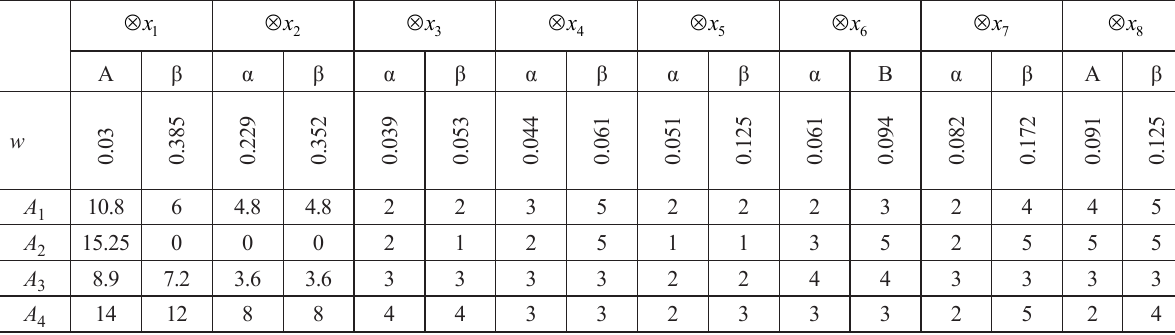
Table 5. Weight factors, criteria and alternatives of the proposed zero-sum two-person matrix game of the delayed project x 1